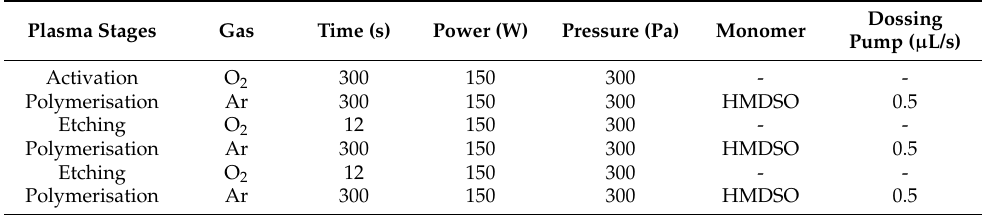
Table 2. Plasma operating conditions of the plasma deposition process.